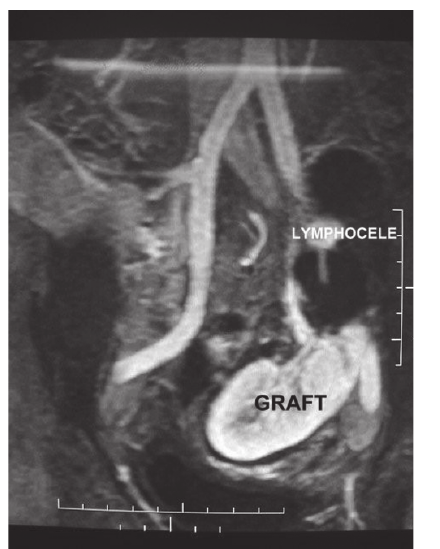
Figure 1 - Magnetic resonance showing an upper pole lymphocele displacing the renal graft.